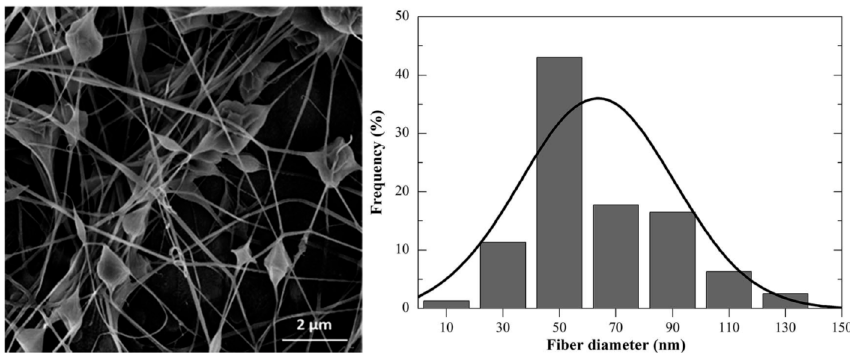
Figure 8. Scanning electron microscopy image optimized electrospun fibers containing PNIPAAm microgels (on the right ) and fiber diameter distribution with a mean fiber diameter of 63 ± 25 nm (on the left ) (Reprinted from ref. [71]).